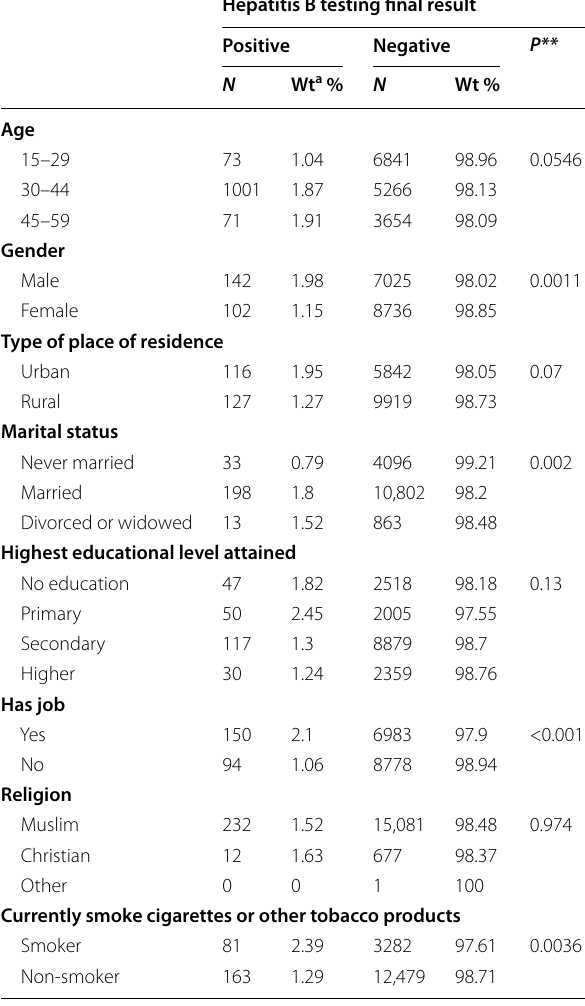
Table 1 Description of the studied population ( n